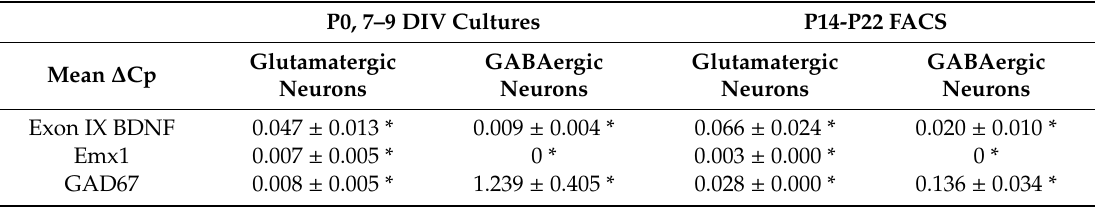
Figure 7. Fluorescence-activated cell sorting (FACS), immunocytochemistry and RT-qPCR from sorted cortical glutamatergic and GABAergic neuron populations. BDNF mRNA quantification from sorted and cultured cell populations: ( A ) Fluorescent scatter of whole neocortex cell homogenate from VGAT-YFP x NexCre-Ai9 transgenic mice with example gates used to segregate both cell populations. ( B) Immunolabeling of the sorted pure cell cultures after 9 DIV with GABAergic cells on the left and glutamatergic cells on the right. The lower panels show the cell-specific neuronal markers, GAD67 and Emx1 and the glial cell marker, GFAP. ( C) Exemplary curves from the RT-qPCR amplification of BDNF. ( D) Specific neuronal markers, GAD67 and Emx1, for GABAergic and glutamatergic neurons. ( E ) Relative quantification of BDNF, GAD67, Emx1 and GFAP in GABAergic cells and BDNF, GAD67 and Emx1 in hippocampal granule cells. ( F ) Relative quantification results for BDNF, GAD67 and Emx1 in GABAergic and glutamatergic neurons: FACS-isolated and cultured for 7–9 DIV and FACS-isolated and pelleted cell samples (pellet). Scale bar: (B), 100 µm. Table 4. Delta-Cp values for transcripts of BDNF and neuronal markers in samples of the two main cortical neuron populations at di ff erent postnatal stages obtained by FACS. P0, 7–9 DIV Cultures P14-P22 FACS